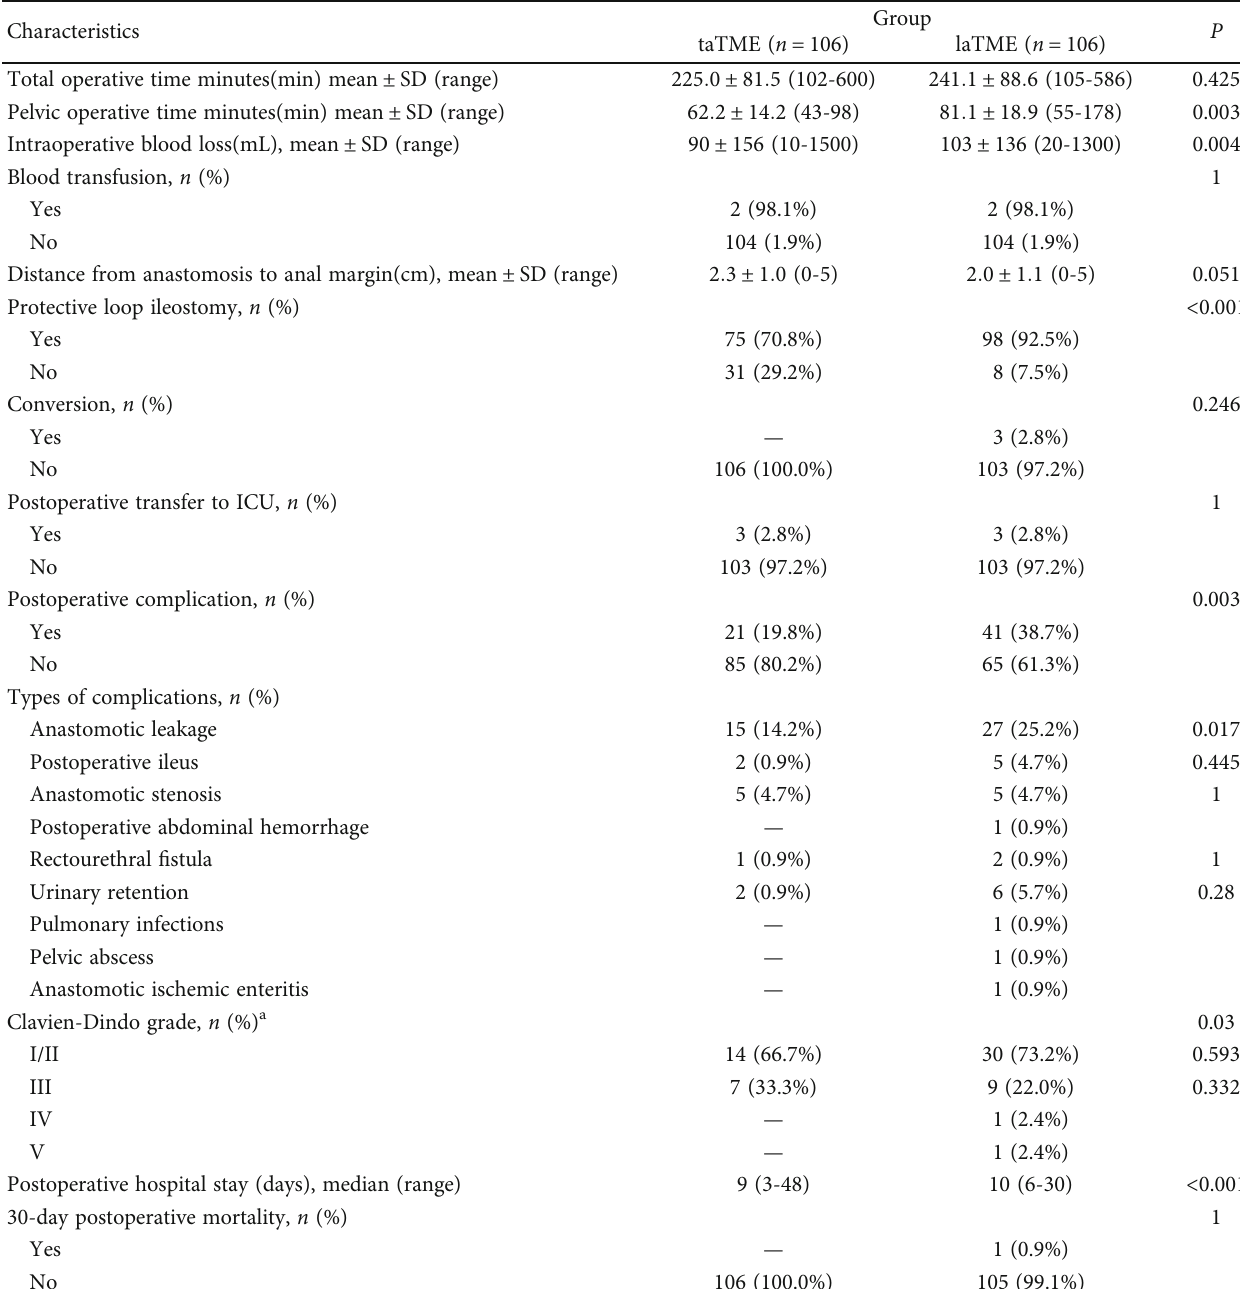
Table 2: Perioperative